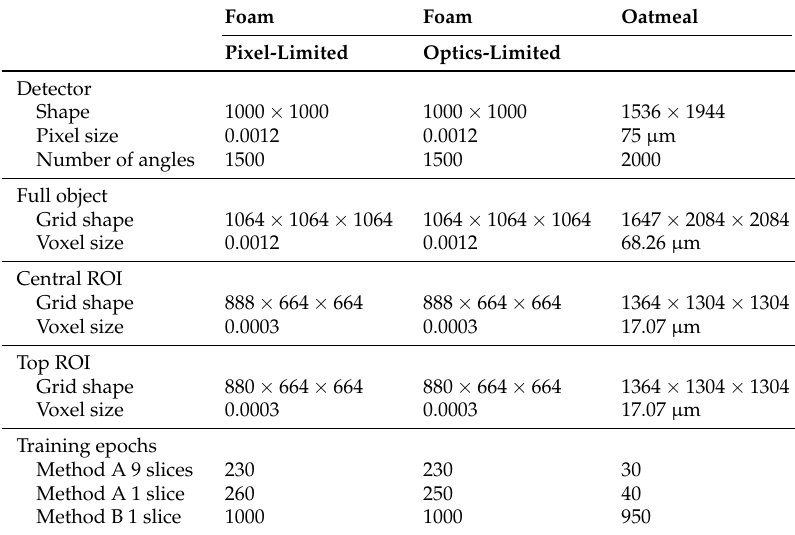
Table 2. A summary of the pixel and voxel grids used for the reconstructions of the full object and regions of interest (ROIs). For each dataset, the network was trained by up-sampling the input (method A) with a slab of nine slices and one slice as input, and by down-sampling the target (method B) with a slab of one slice as input.